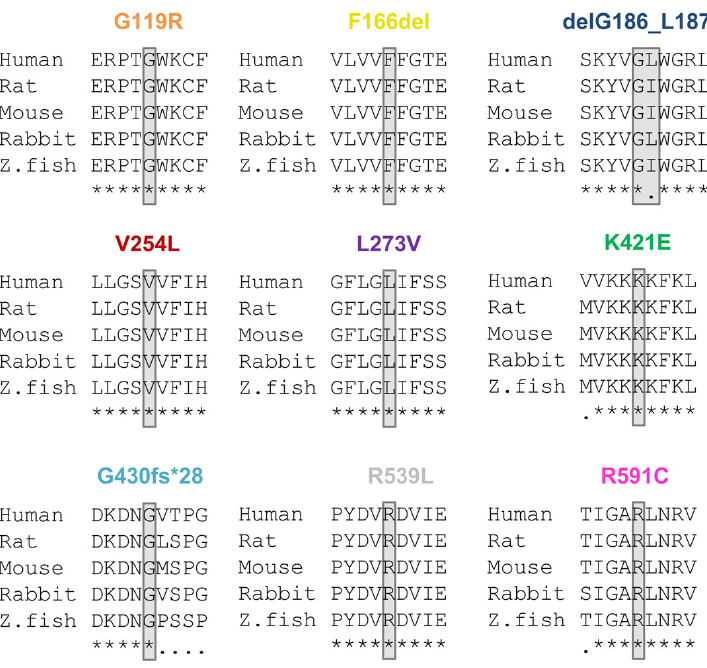
Figure 2. Protein sequence alignments illustrating the KCNQ1 variants in different orthologues. Partial amino acid alignments showing the mutated amino acids of the patients highlighted in gray. Below the sequences, conserved amino acids are marked with “*“and non-conserved amino acids are marked with